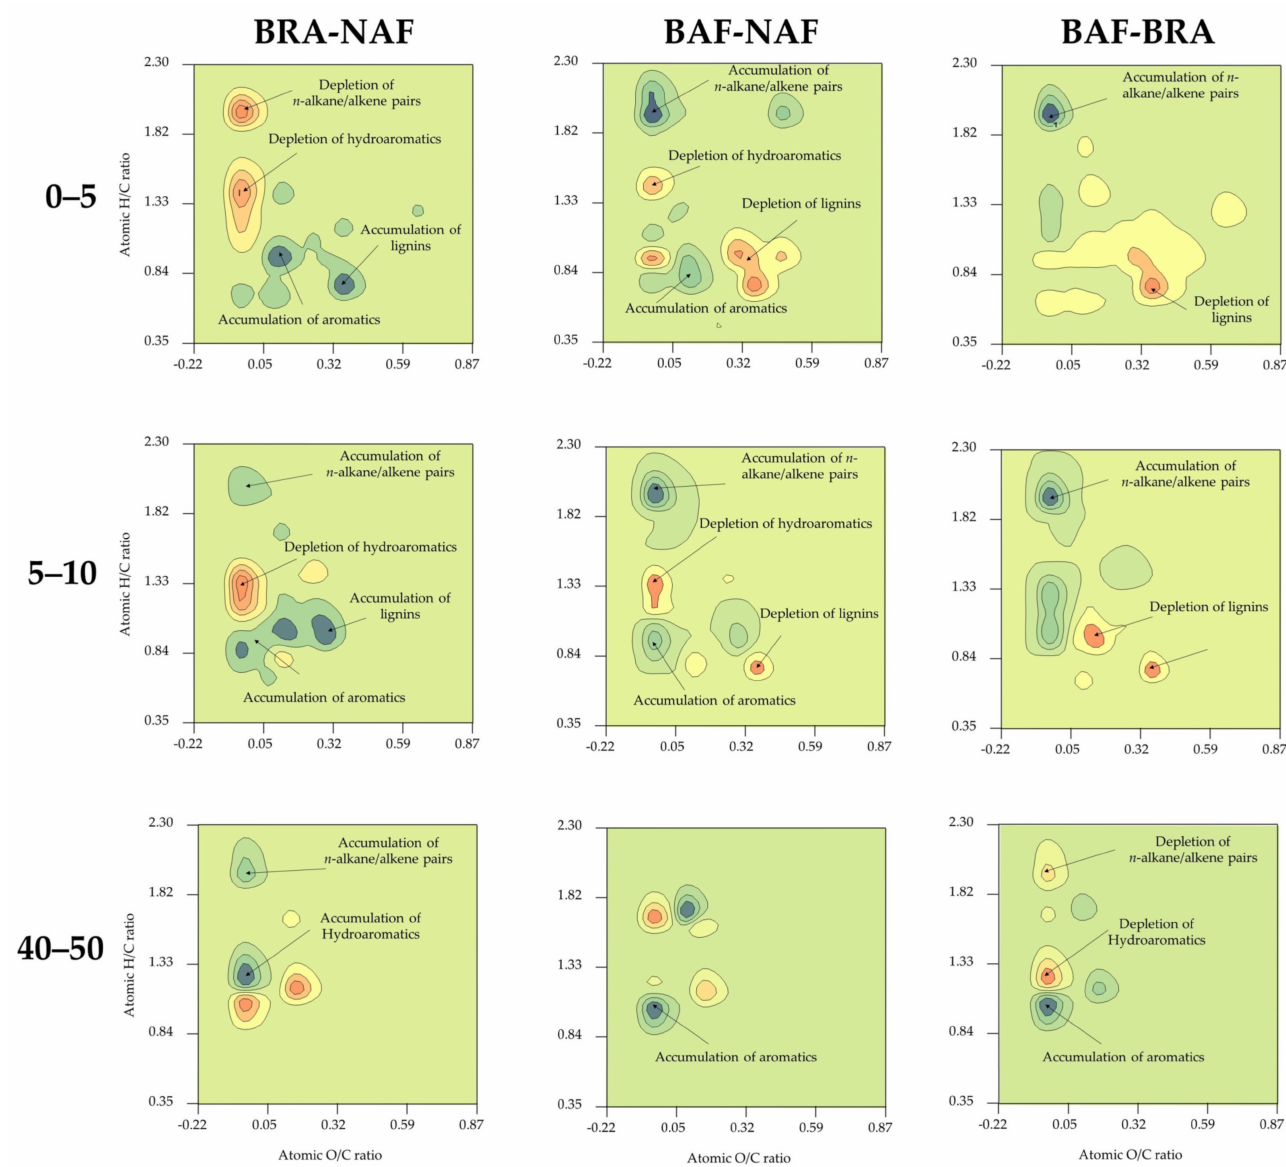
Figure 4. Subtraction density maps illustrating differences in abundance of pyrolysis products between soil samples collected at the native Amazon Forest (NAF), burned Amazon Forest (BAF) and Brachiaria (BRA) site at 0–5, 5–10 and 40–50 cm depth. Maps are represented in the space defined by the H/C and O/C atomic ratios of the corresponding compounds. Enrichment of compounds is shown in blue anddepletion in